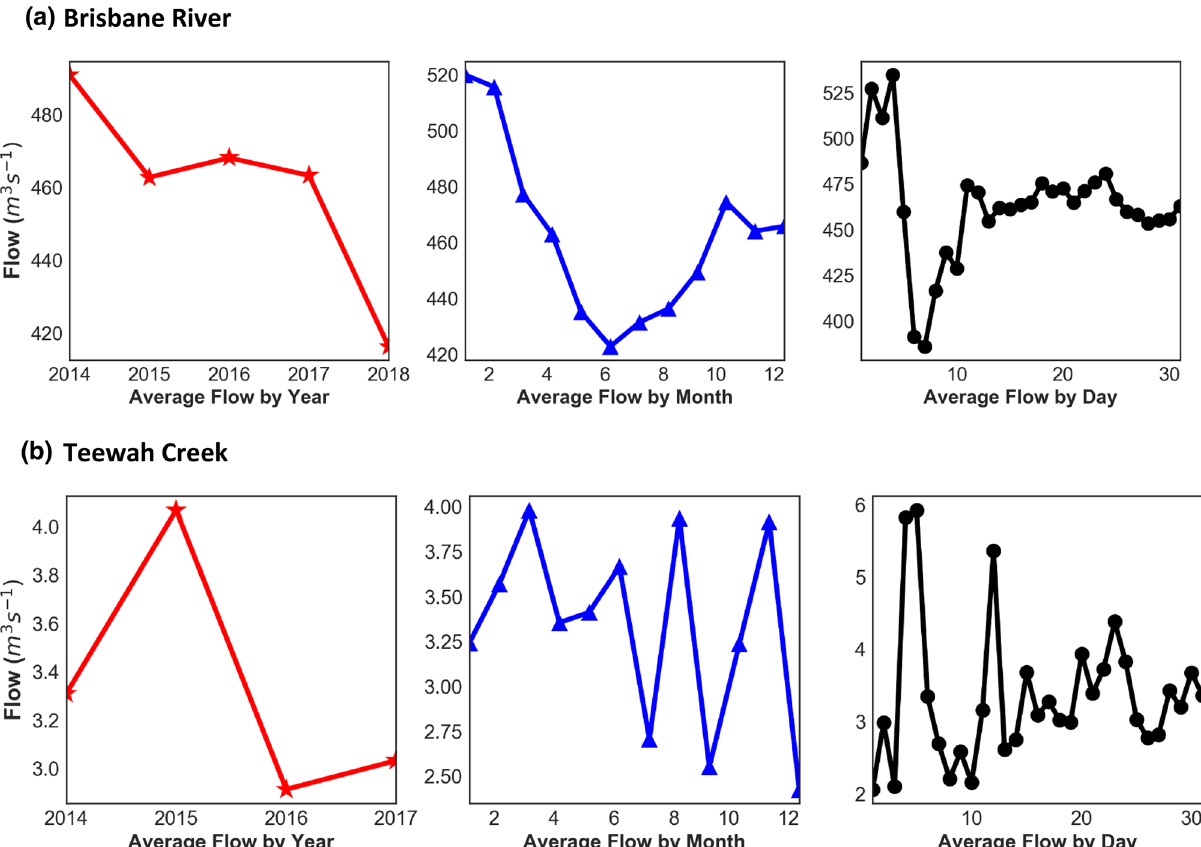
Figure 6. Variation of streamflow ( Q , m 3 s −1 ) by year, month and day for ( a ) Brisbane River and ( b ) Teewah